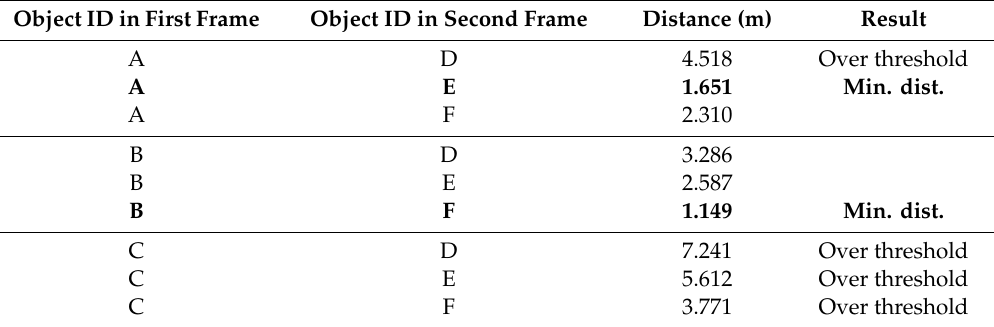
Table 1. Result of tracking and indexing algorithm using threshold and minimum distance. Object ID in First Frame Object ID in Second